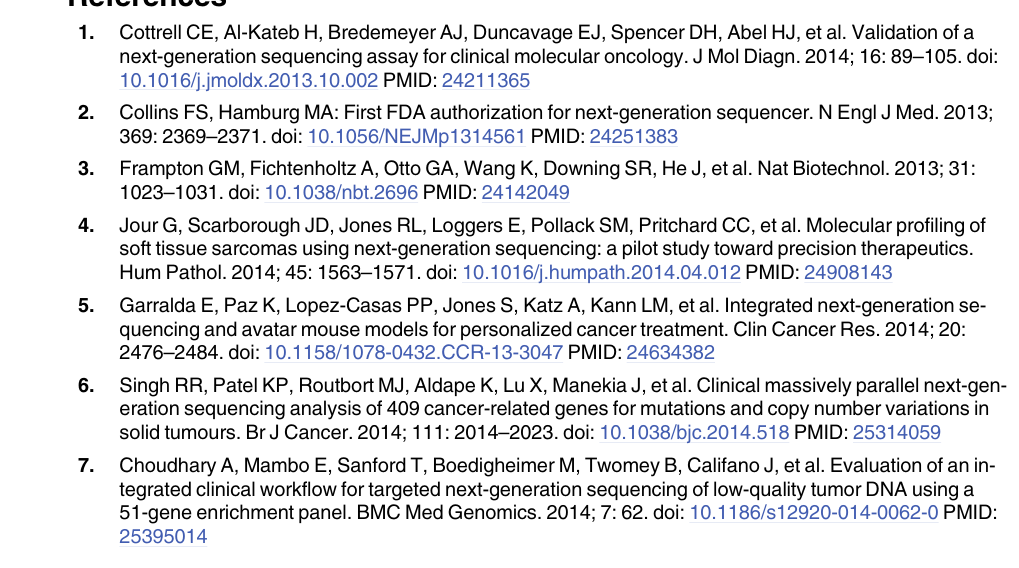
S2 Table. Key differences of the UNCseq sequencing, bioinformatics pipeline, and valida- tion of tissue samples between the 07 – 0120 and 11 – 1115 cohort. Abbreviations : SF, snap- frozen; FFPE, formalin-fixed paraffin-embedded; bp, base pair; PCR, polymerase chain reac- tion; CLIA, clinical laboratory improvement amendments. S3 Table. List of mutations identified in the 24 tumor tissue samples collected as part of the 11 – 1115 tissue cohort using three methods to call mutations (matched normal, pooled nor- mal, and normal free variant calling). Abbreviations: SF, snap-frozen; FFPE, formalin-fixed paraffin-embedded; SNV, single-nucleotide variations; CLIA, clinical laboratory improvement amendments; SOC, standard of care assays used by CLIA-certified Molecular Pathology labo- ratories to report mutations for clinical use; PPH2, PolyPhen 2; MAF, mutant allele frequency; Nonsyn., Nonsynonymous; Nonframe., Nonframeshift; Frame., Frameshift; ins., insertion; del., deletion; dam., damage. S1 Text. Definitions for depth of coverage (or read depth), breath of coverage, on-target rate, and expected mutant allele